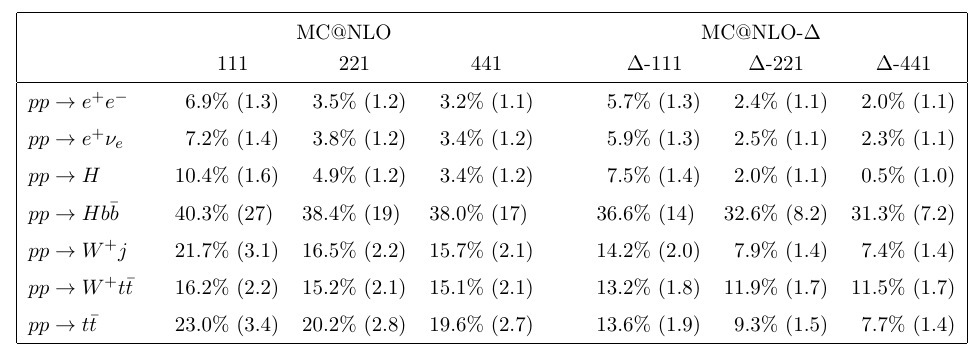
Table 1 . Fractions of negative-weight events, f , and the corresponding relative costs, c ( f ) (in round brackets), for the processes in eqs. (5.7){(5.13), computed with MC@NLO (columns 2{4) and with MC@NLO-(cid:1) (columns 5{7), for three di(cid:11)erent choices of the folding parameters. matching (including the fractions of negative-weight events) are concerned. This allows one to obtain a reasonably complete comparison between MC@NLO and MC@NLO-(cid:1)